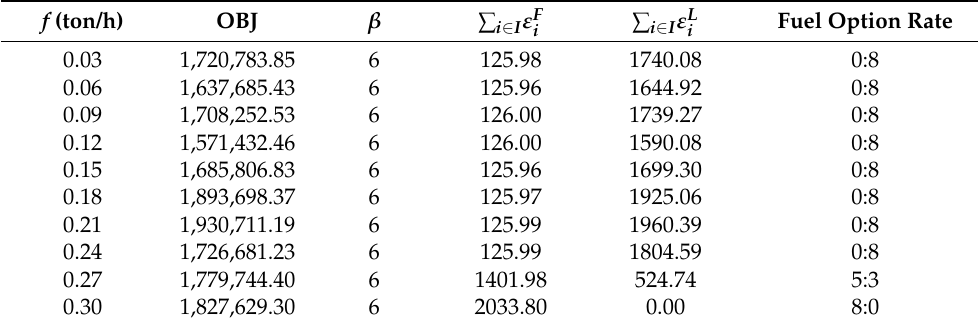
Table 5. Impact of methane slip amount on the operation decisions.